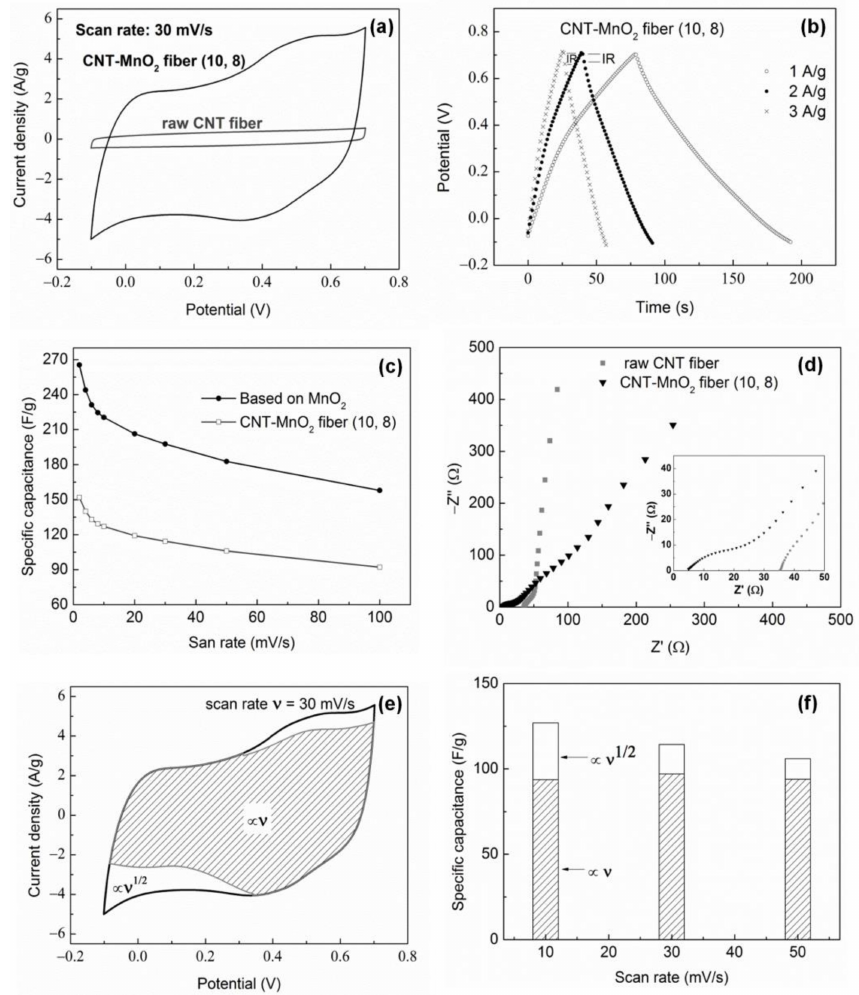
Figure 8. Electrochemical characterization of CNT–MnO 2 fiber electrode (working electrode) in a three-electrode cell using 1M Na 2 SO 4 (aq) as electrolyte: ( a ) comparison of CV curves of raw CNT fiber and CNT–MnO 2 fiber (10, 8) electrodes; ( b ) CP curves of CNT–MnO 2 fiber (10, 8) electrode at various current densities; ( c ) specific capacitance for the CNT–MnO 2 fiber (10, 8) electrode and the deposited MnO 2 at different scan rates; ( d ) Nyquist plots of CNT fiber and CNT–MnO 2 fiber (10, 8) electrodes. ( e , f ) Deconvolutions of two contributions to the capacitance in CNT–MnO 2 fiber (10, 8): the diffusion-limited process ( ∝ ν 1/2 , blank regions) and the surface-limited process ( ∝ ν , shaded regions). ( e ) CV at 30 mV/s and ( f ) bar graph of the two contributions versus the scan rate ν